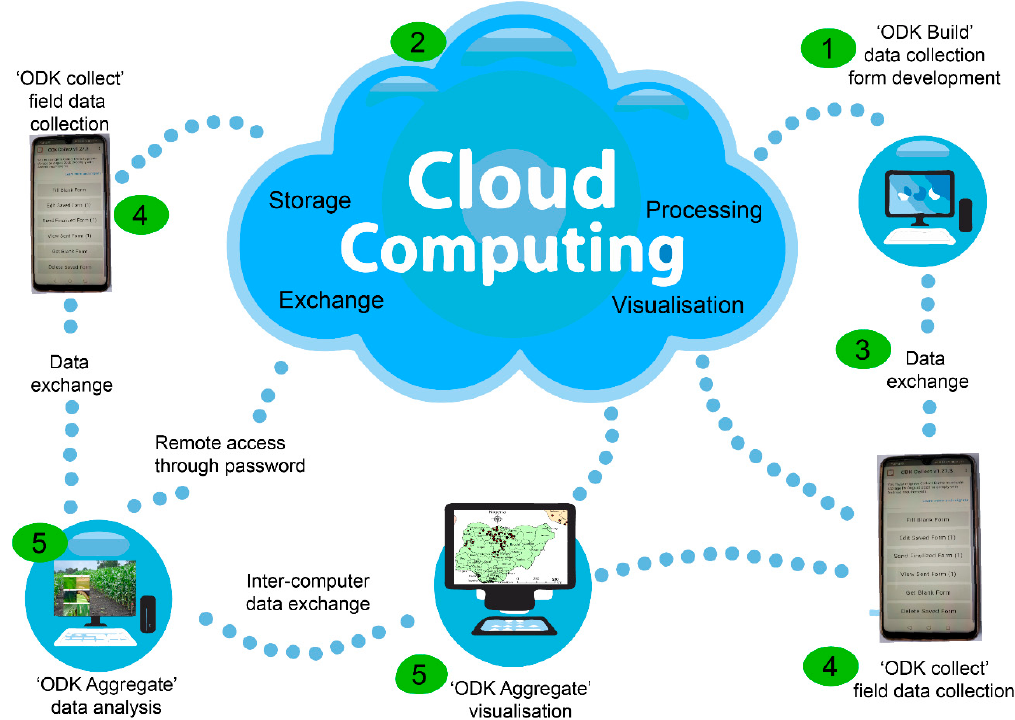
Figure 2. Open data kit ( ODK) data collection workflow and the mobile smartphone interface for data collection through ODK Collect.